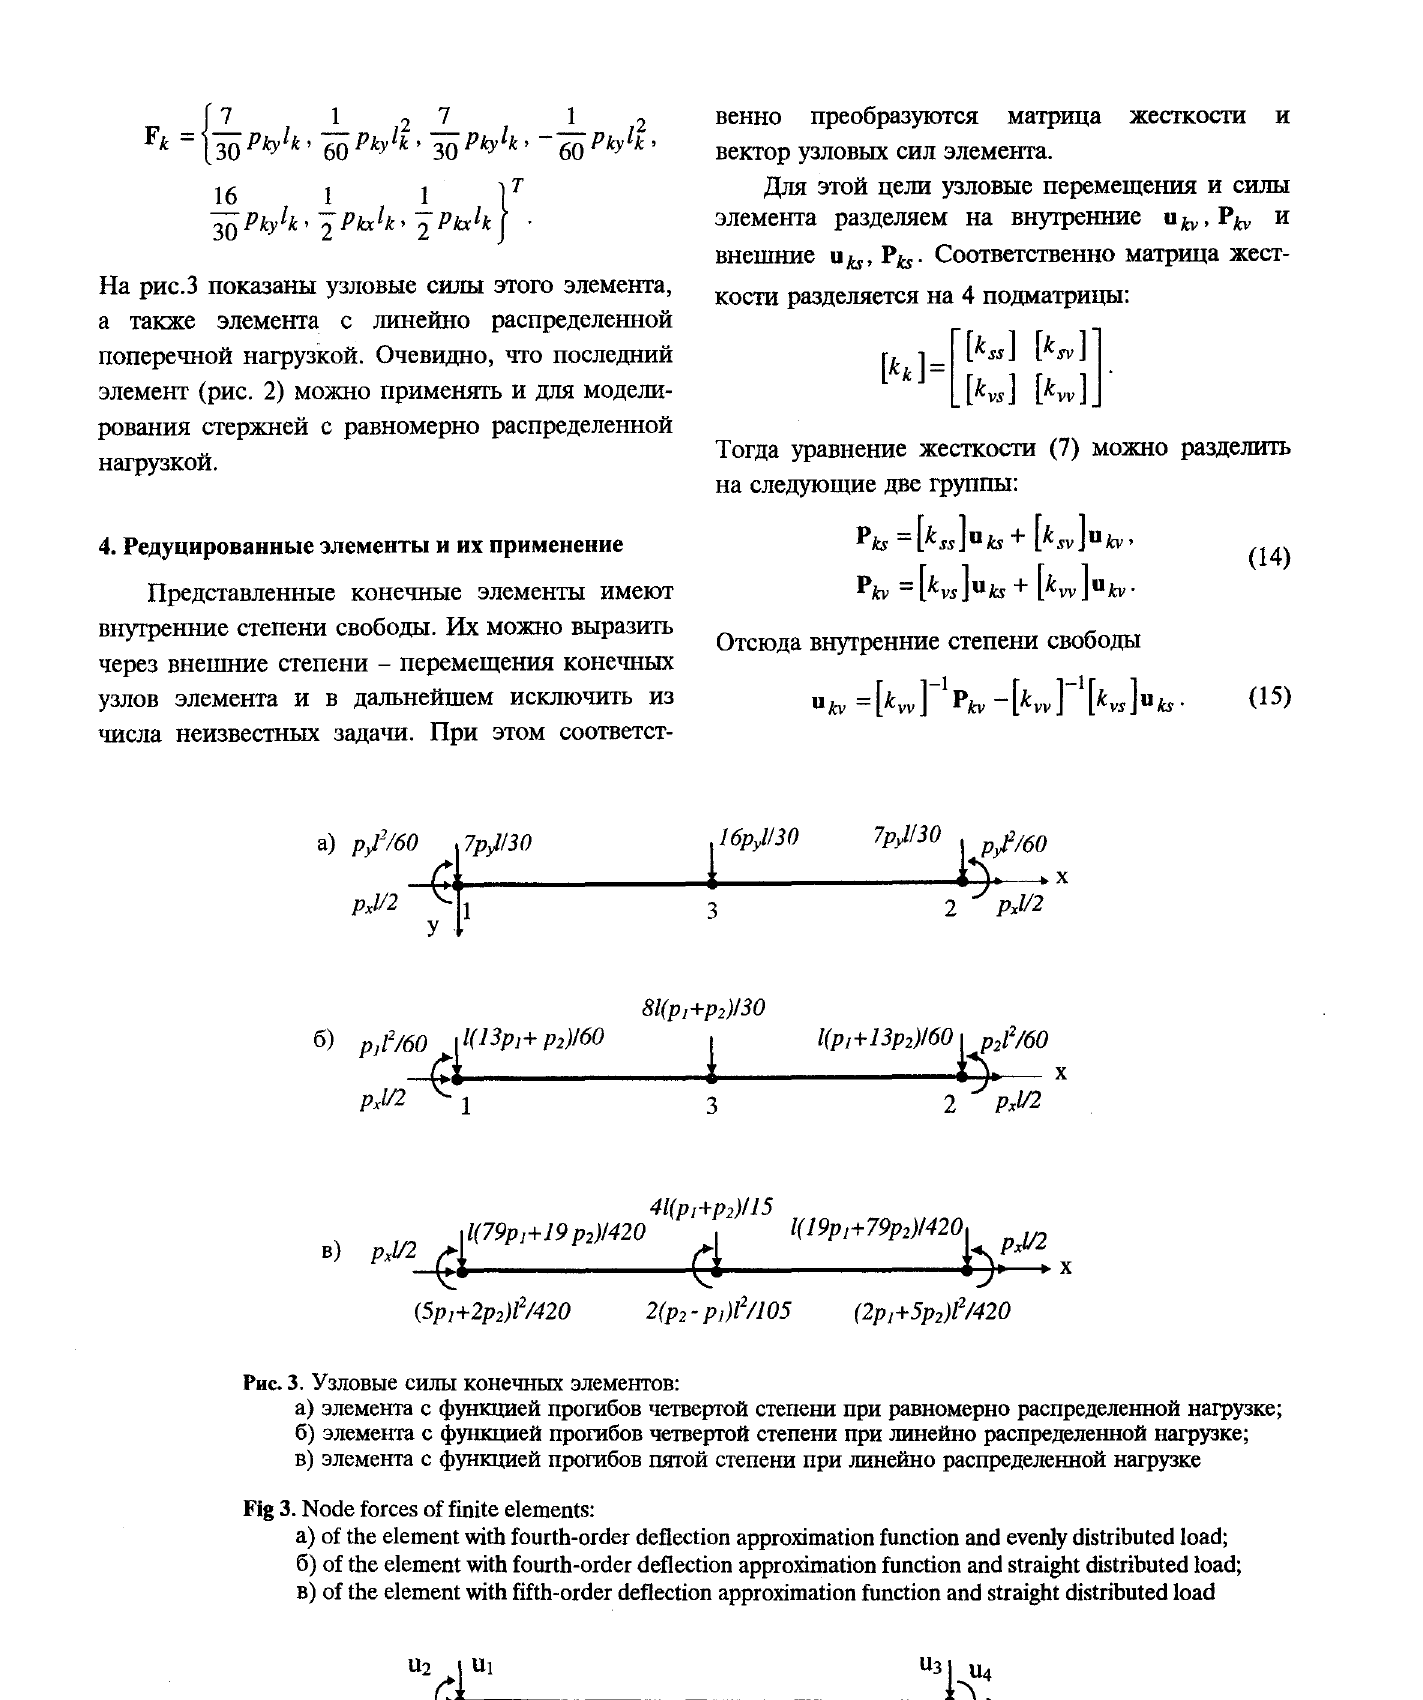
Fig 3. Node forces of finite elements: